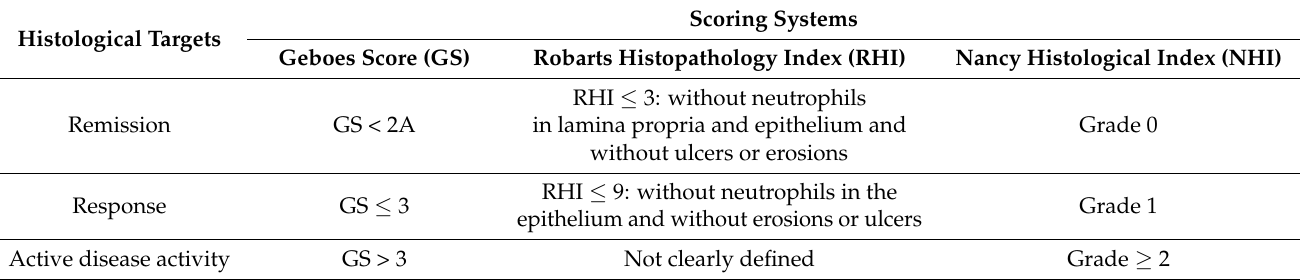
Table 2. Summary of the scoring system in histologic target in